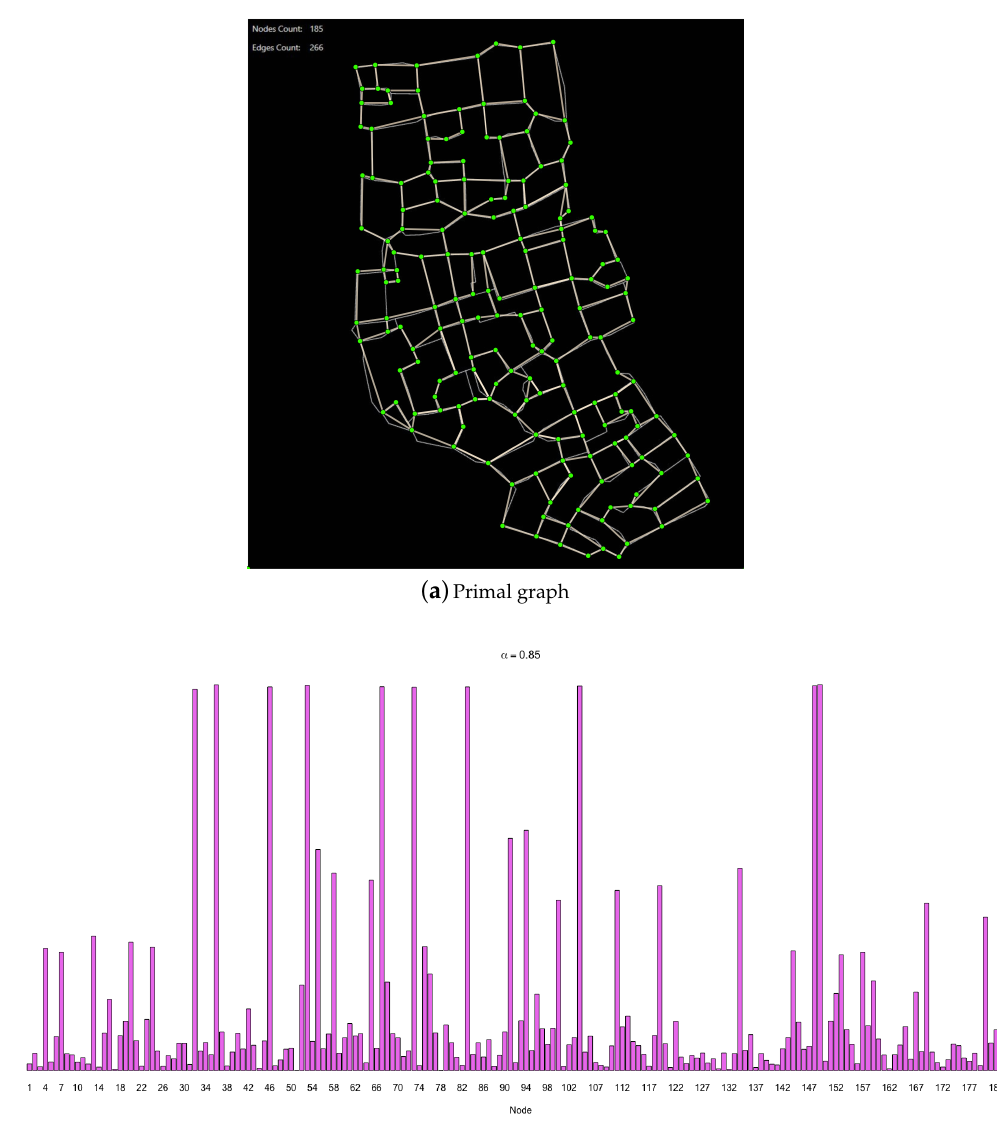
Figure 6. An example of a real urban